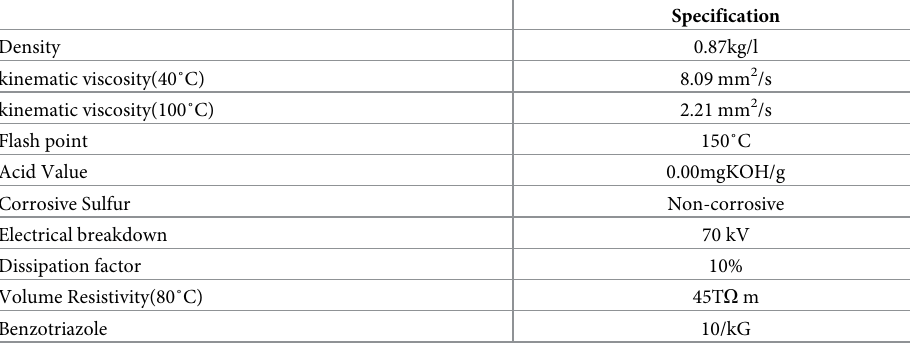
Table 2. The details of the transformer oil